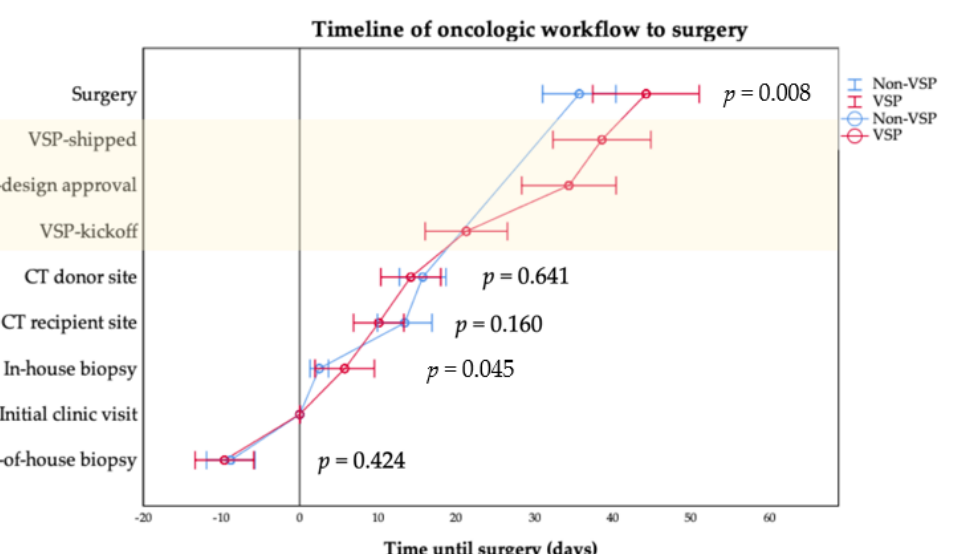
Figure 3. Mean time of diagnostic and planning procedure from the initial clinic visit to surgery categorized by method of reconstruction planning. The 95% confidence intervals are given by whisker bars. Statistically significant differences were found for intervals of the initial clinic visit to in-house biopsy ( p = 0.045) and surgery ( p = 0.008) (Table 3). Annotation: The light yellow background marks VSP parameters.